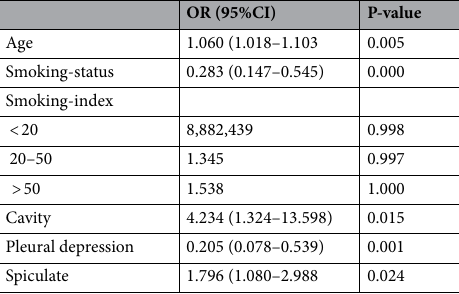
Table 2. Logistic regression analysis of clinical